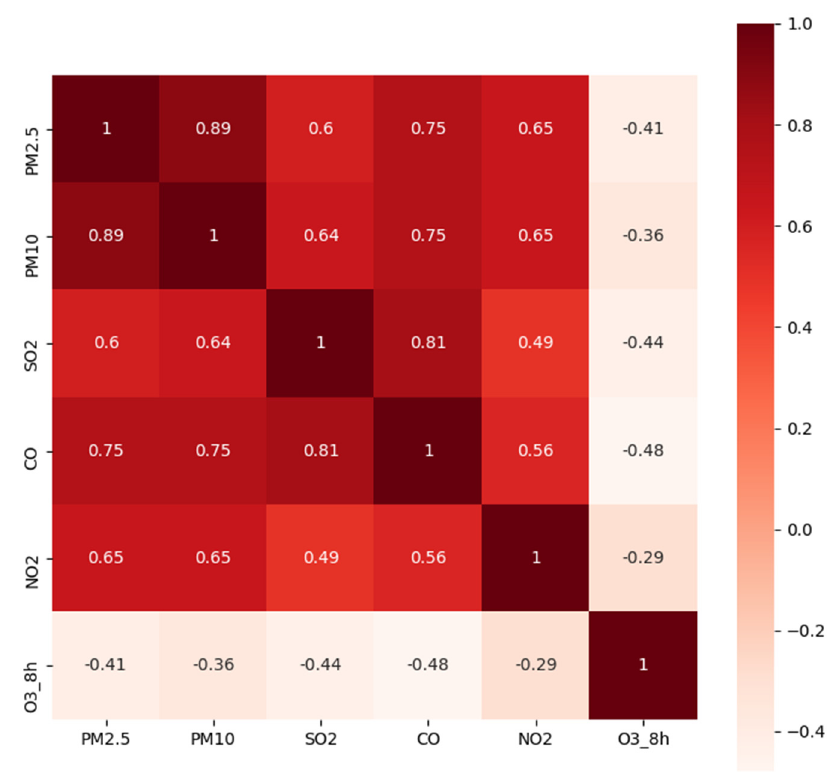
Figure 2. Pearson Analysis of six air pollutants.